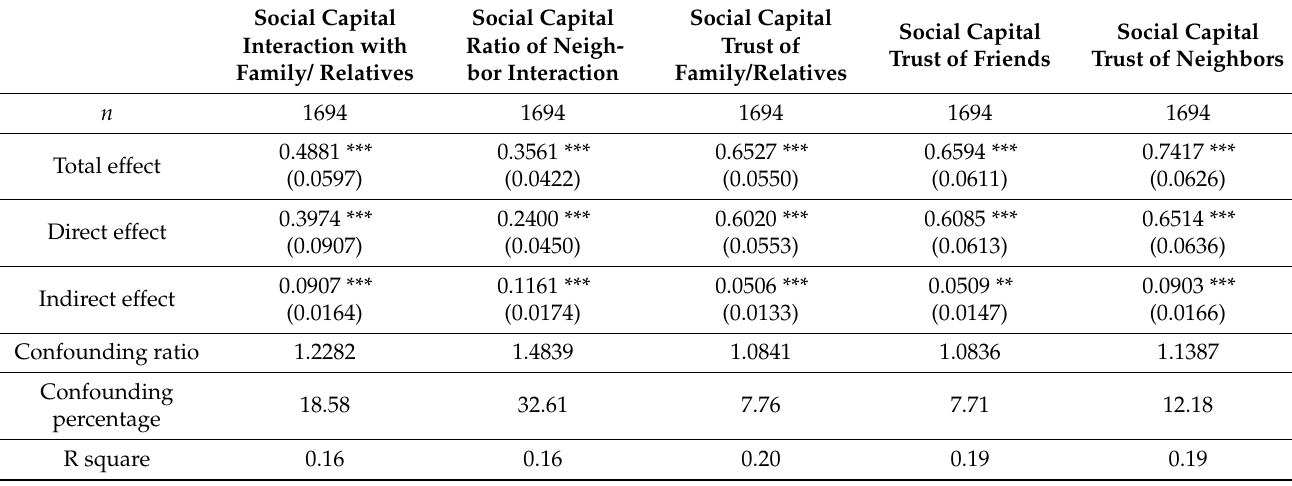
Table 4. Regression for effects for the association between social capital and happiness, mediated by festival participation.